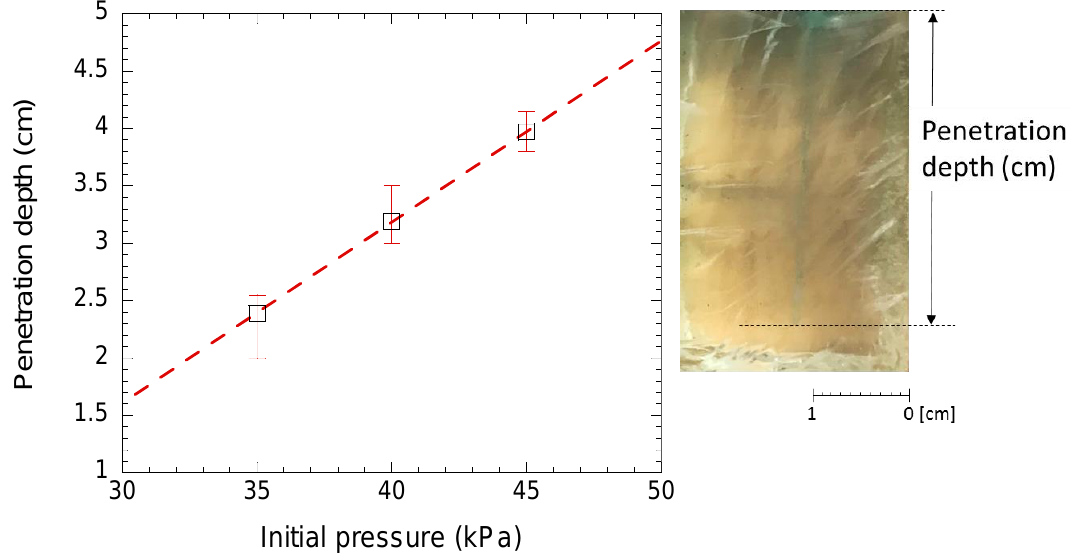
Figure 8. A liquid jet injection by the present detonation-driven injector device into a bloom 250 10% wt. gel as a function of mixture initial pressure.